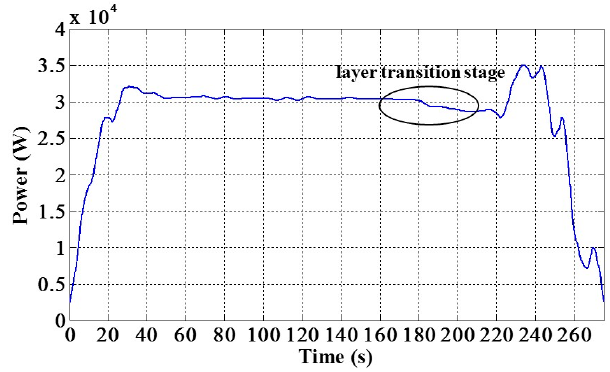
Figure 6. Sixth-level approximation of the motor power signal by wavelet analysis.